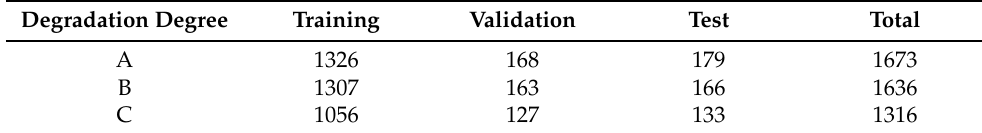
Table 5. Number of images in the distress type of concrete spalling. Degradation